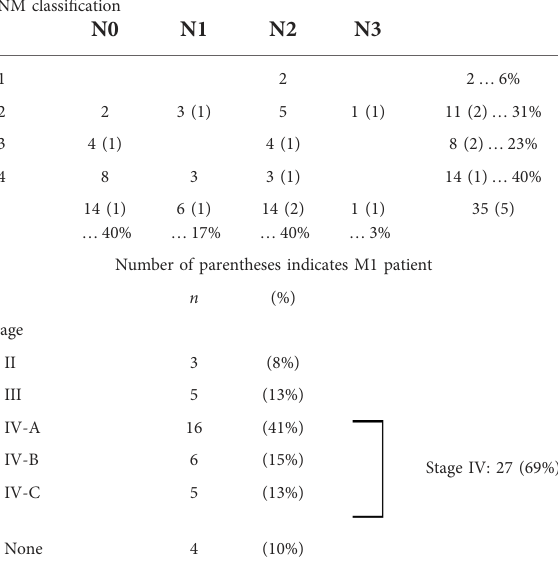
TABLE 2 TNM classi fi cation and stage of patients.